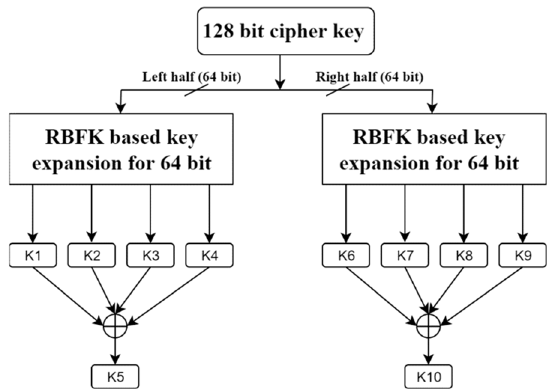
Fig. 3 RBFK based key scheduling for 64-bit cipher key Fig. 4 RBFK based key scheduling for 128 bit cipher